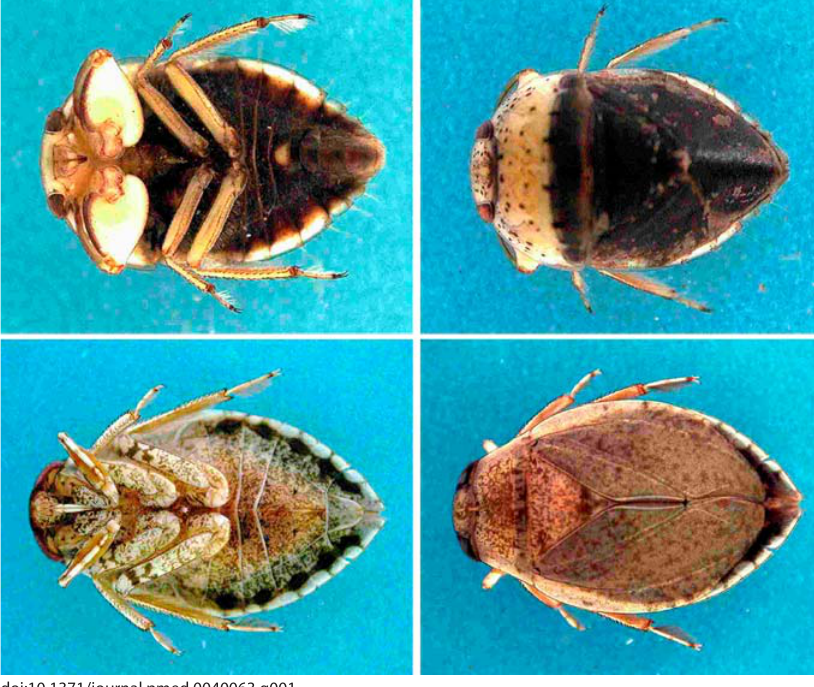
Figure 1. Semiaquatic Hemiptera That Have Tested Positive for M. ulcerans The top two images show Macrocoris sp. 1.0 cm in body length (family Naucoridae), and the bottom two images show Appasus sp., about 2.5 cm in body length (family Belostomatidae). The ventral and dorsal views are in the left and right photographs, respectively. Photo from